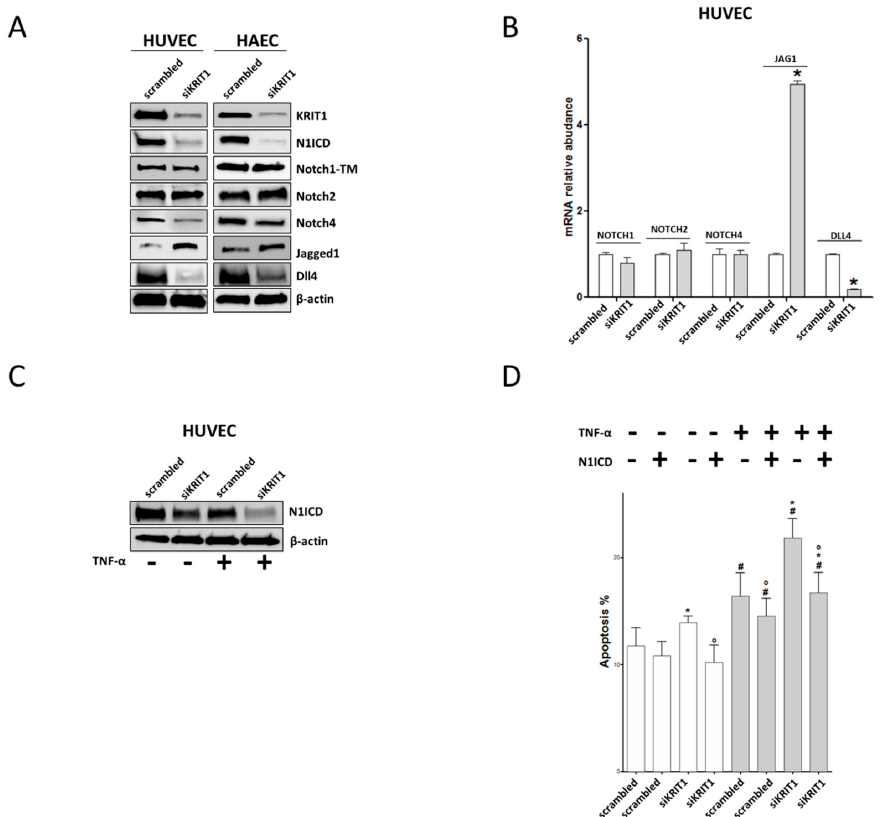
Figure 3. KRIT1 downregulation leads to endothelial dysfunction through a redox-sensitive inhibition of Notch1: ( A ) Western blotting analysis of Notch receptors and ligands in HUVECs and HAECs transfected with scrambled siRNAs or siRNAs against KRIT1: β -actin was used as loading control. ( B ) qRT-PCR quantification of the mRNA levels of Notch receptors and ligands in HUVECs transfected with scrambled siRNAs or siRNAs against KRIT1: Relative changes in mRNA expression levels were calculated according to the 2 −ΔΔ Ct method using RPL13A as reference gene. Results are expressed as mean ± S.D. of three independent experiments, each performed in triplicate. * p < 0.01 (pairwise comparison between scrambled and KRIT1 siRNAs). ( C ) Western blotting analysis of N1ICD in HUVECs transfected with scrambled siRNAs or siRNAs against KRIT1 and treated for 24 h with TNF- α 10 ng/mL. ( D ) Apoptosis levels of HUVECs co-transfected with scrambled siRNAs or siRNAs against KRIT1 and pcDNA3, empty or encoding for N1ICD, and treated for 24 h with TNF- α 10 ng/mL: Data are expressed as mean ± S.D. of 4 independent experiments. Multiple comparison one-way ANOVA test with Student-Newman-Keuls was used. * p < 0.05 (pairwise comparison between plus or minus siRNA); ° p < 0.05 (pairwise comparison between N1ICD or empty pcDNA3); and # p < 0.05 (pairwise comparison between plus or minus TNF- α ).